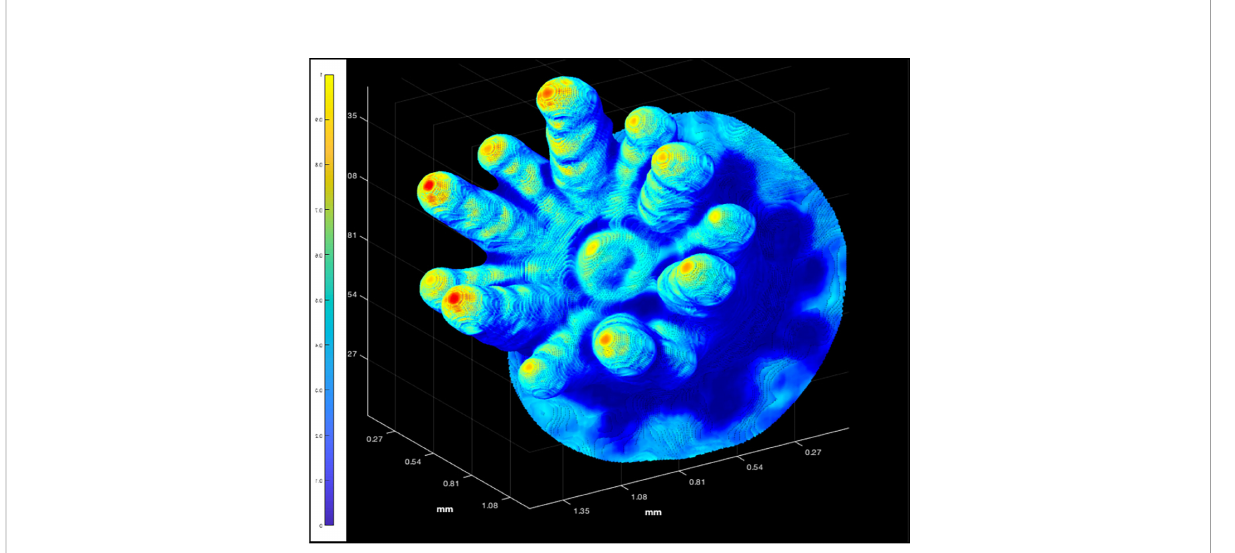
FIGURE 6 The 3D point cloud for an individual polyp of P. damicornis (Polyp 6 in Figure 2). The color bar highlights that the backscatter range was rescaled linearly from 1 = highest value, to 0 = lowest value, using the original backscatter values from the interpolated, unprocessed, OCT data as